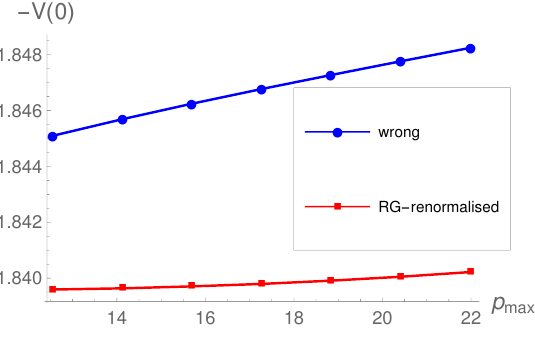
Figure 1. The physical vertex V ( 0 ) versus p max with λ = 2, T = 2 and L = 4 at 4 loop level in the skeleton expansion. To set the scale we also show the results of an incorrect calculation (see text for more